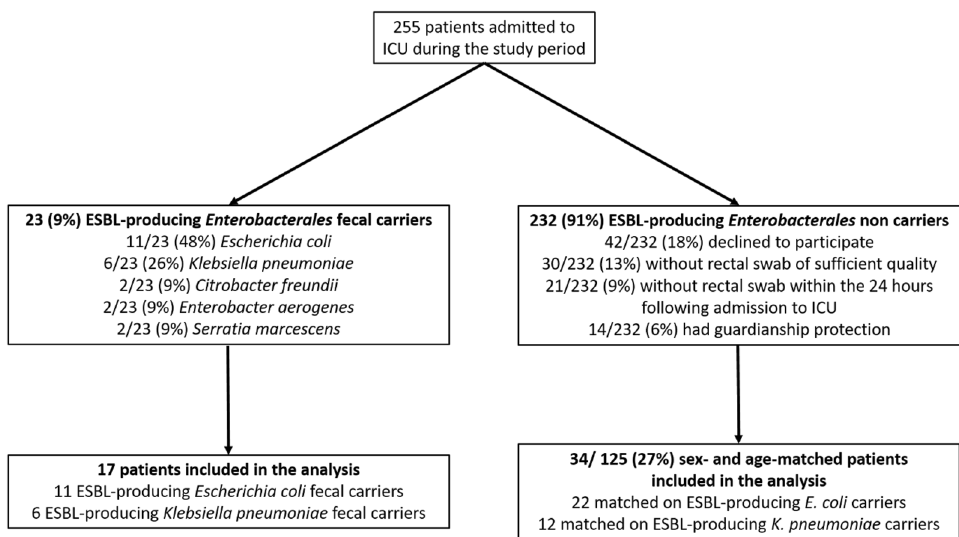
Fig. 1 Flow-chart. ESBL extended-spectrum beta-lactamase, ICU intensive care